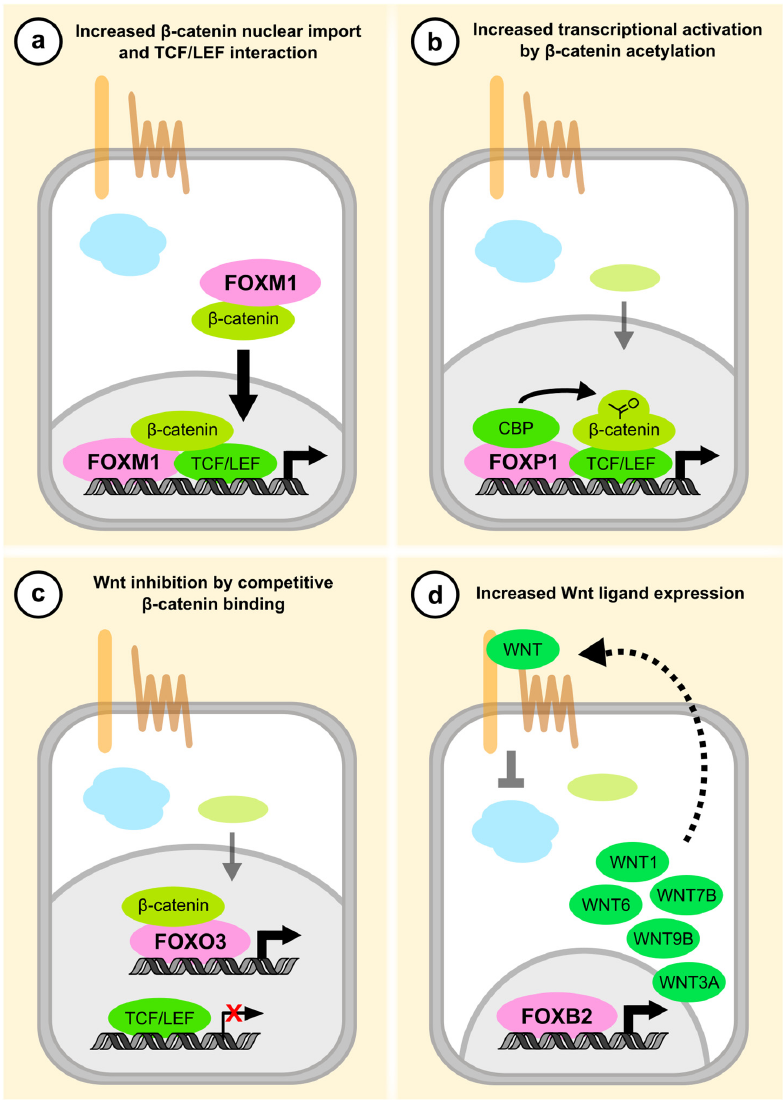
Figure 3. Proposed mode of action of selected FOX transcription factors in the Wnt signaling pathway.